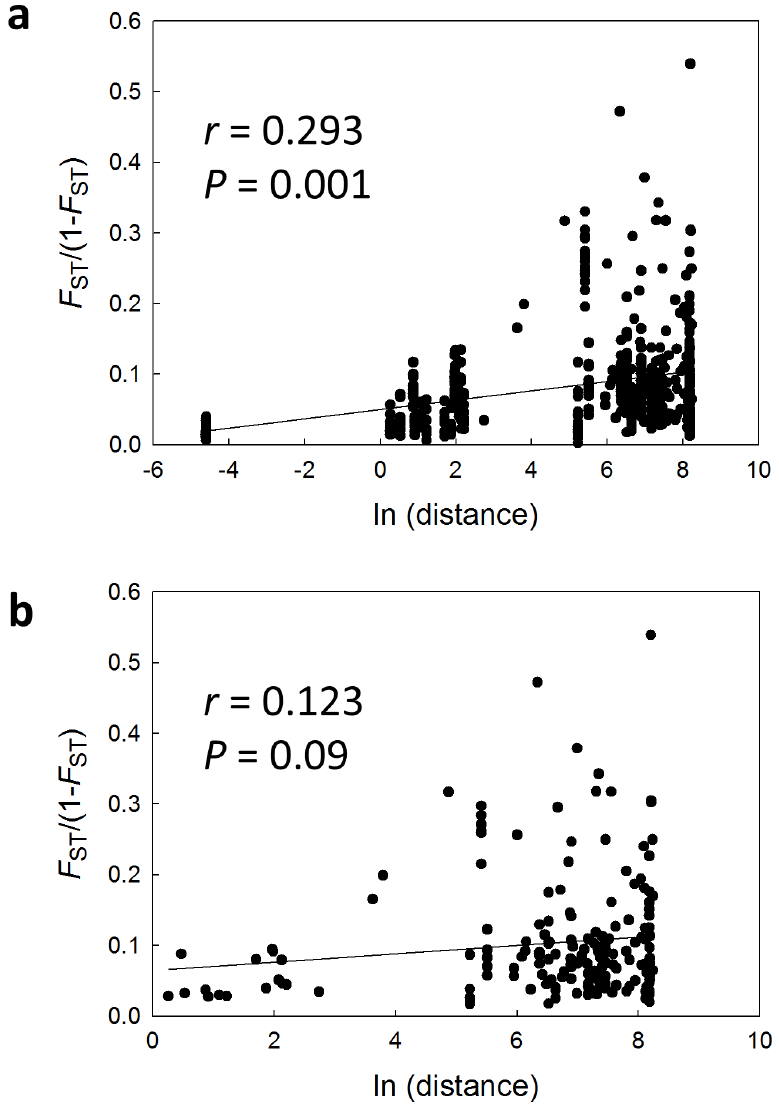
Figure 2. Isolation by distance analysis for B.germanica populations across the U.S. Pairwise comparisons between populations are plotted as genetic distance transformed as F ST /(1- F ST ) versus the natural log of geographic distance. The correlation coefficient ( r ) and results for the Mantel test of significance are given for (a) all U.S. populations, including comparisons between apartments within the same complex in Raleigh, North Carolina; and (b) for comparisons between populations in the continental U.S. using six populations from Raleigh, one population from each of the studied apartment complexes (LS-A, CR-A, CS-A, DR-X, DRD-X, FC-X).